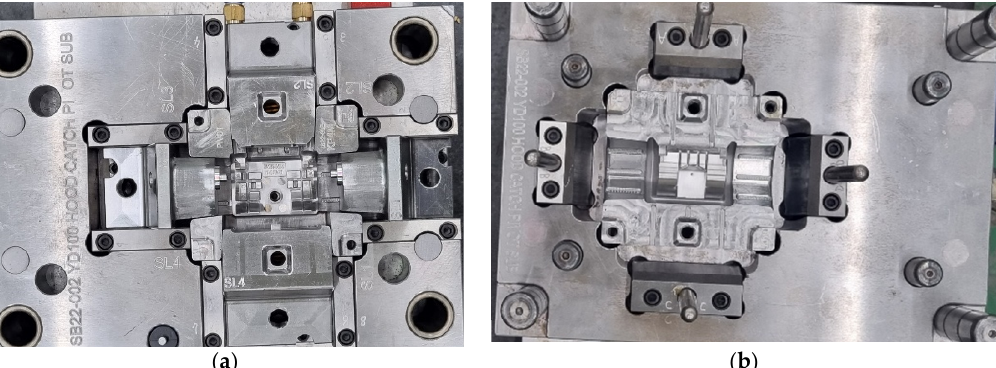
Figure 17. Mold of the pivot sub-assembly applying 0.2% shrinkage-rate constant. ( a ) Lower part. ( b ) Upper part. Table 26. Actual product results of dimensions 1, 2, and 3 for the pivot sub-assembly applying 0.2% shrinkage-rate constant.